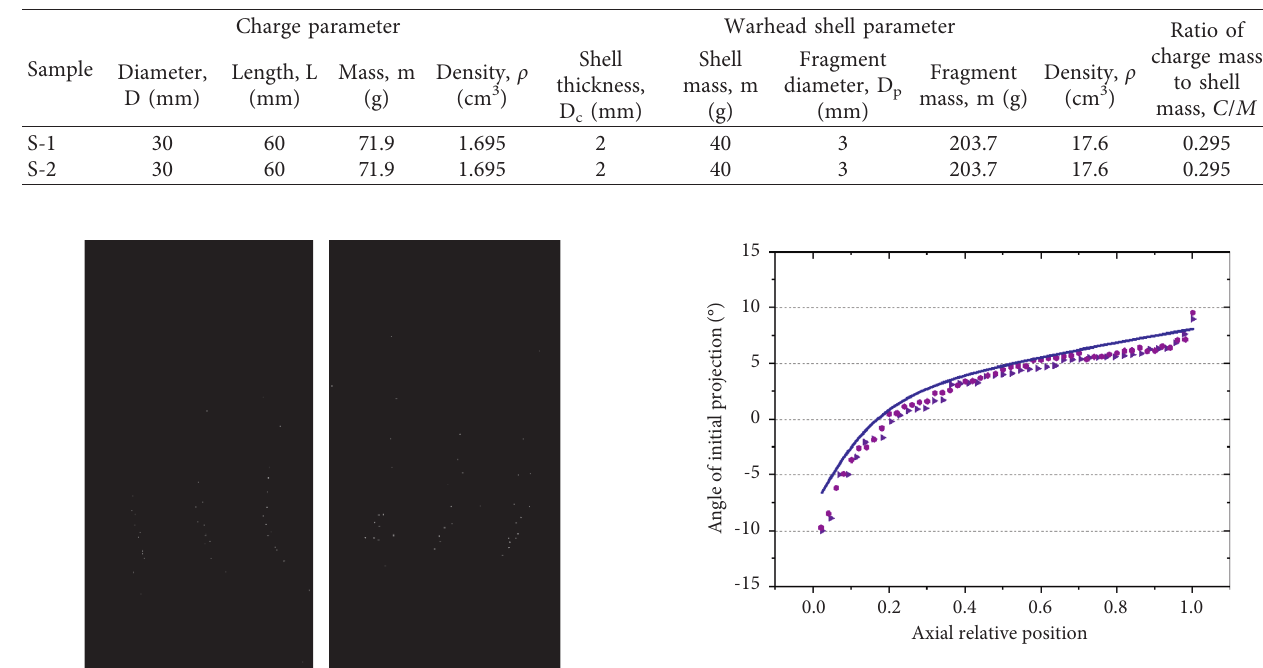
Figure 10: Error analysis of fragmentation dispersion model. (a) Axial relative position error. (b) Dispersion distribution error. (c) Percentile error. Table 3: Specimen parameters used in the validation test for the proposed model.